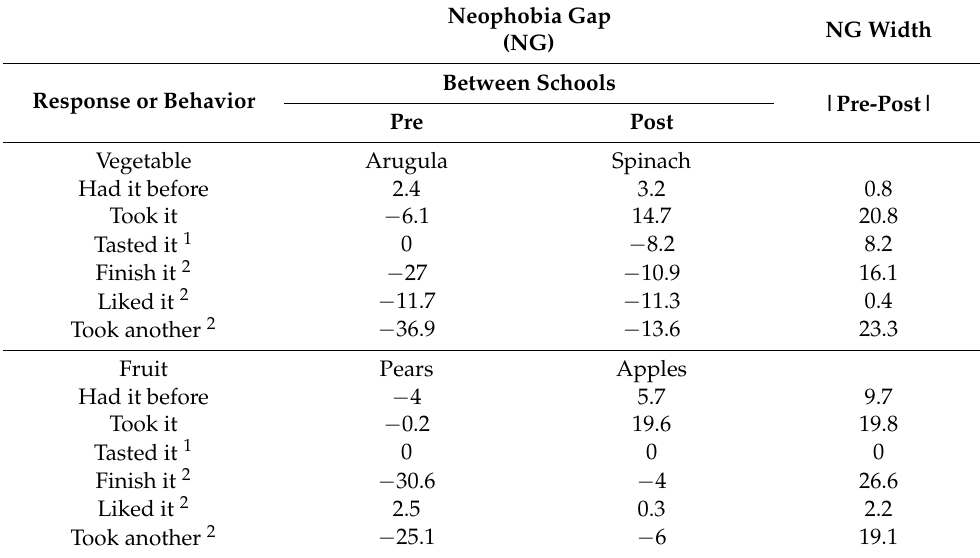
Table 4. Comparison of Neophobia Gap (see full data table in Appendix A, Table 2) Between the Intervention School ( n = 95) and the Control School ( n =